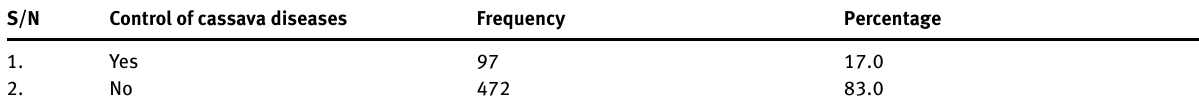
Table 6: Farmers’ Practice of control of cassava diseases S/N Control of cassava